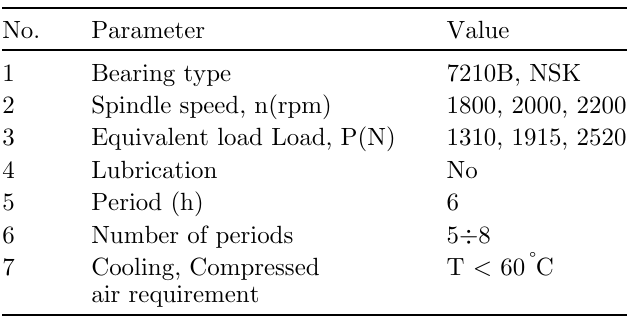
Fig. 2. A schematic view of the experimental apparatus. Table 1. The basic technical parameters of the experi- Table 2. Experimental parameters ments [20].